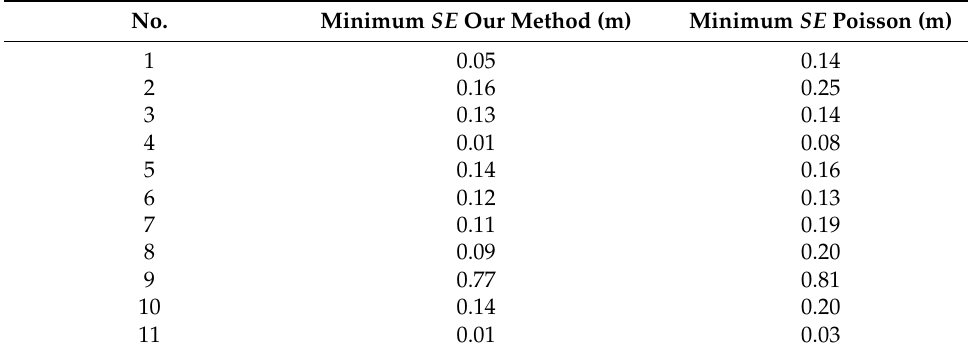
Figure 12. SE of the data association based on the procedure and the Poisson. Table 7. SE of two different initialization